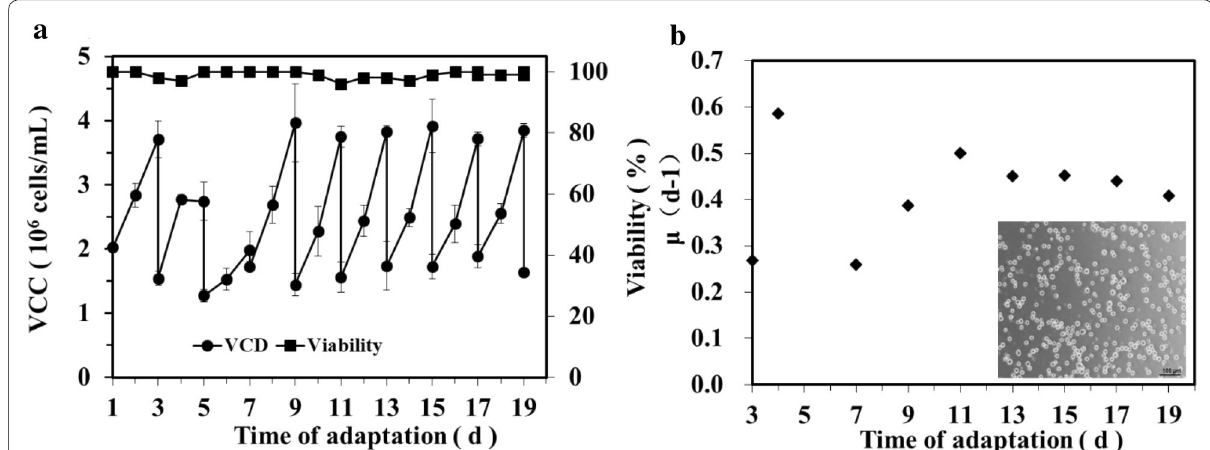
Fig. 1 Adaptation of adherent MDCK cells to suspension growth in Xeno serum‑free medium. a Viable cell concentration (black circle) and cell viability (black square) over the period of adaptation. b Cell‑specific growth rate (black diamond) of MDCK cells over the adaptation. The inset in the panel is a microscopy picture showing the morphology of the adapted suspension MDCK cells. Error bars represent the standard deviation of three analytical